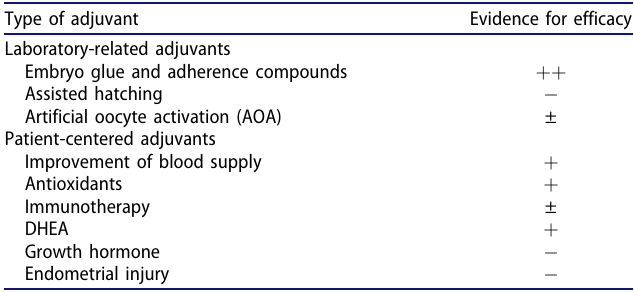
Table 1. Two broad categories are discussed, adjuvants that are related to the IVF laboratory per se and involve gametes or embryos, and medical adju- vants which include patient-centered treatments or